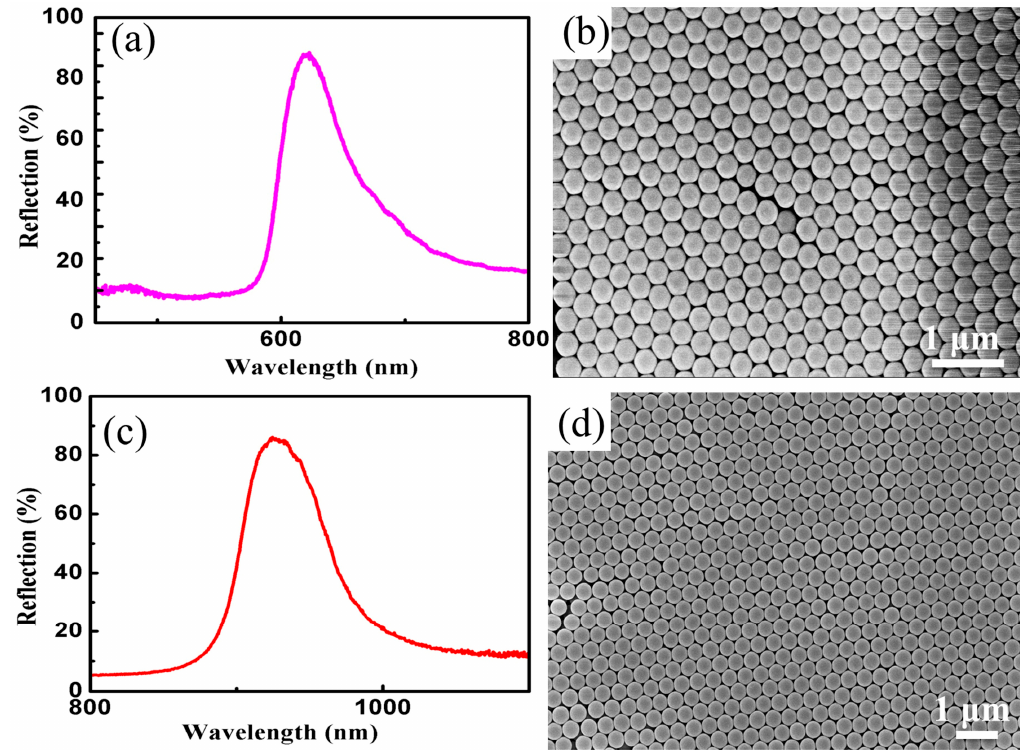
Figure 6. ( a ) Reflection spectrum of 283 nm SMs; ( b ) SEM image of photonic crystals (PCs) formed by self-assembly of 283 nm SMs; ( c ) Reflection spectrum of 427 nm SMs; ( d ) SEM image of PCs formed by self-assembly of 427 nm SMs.